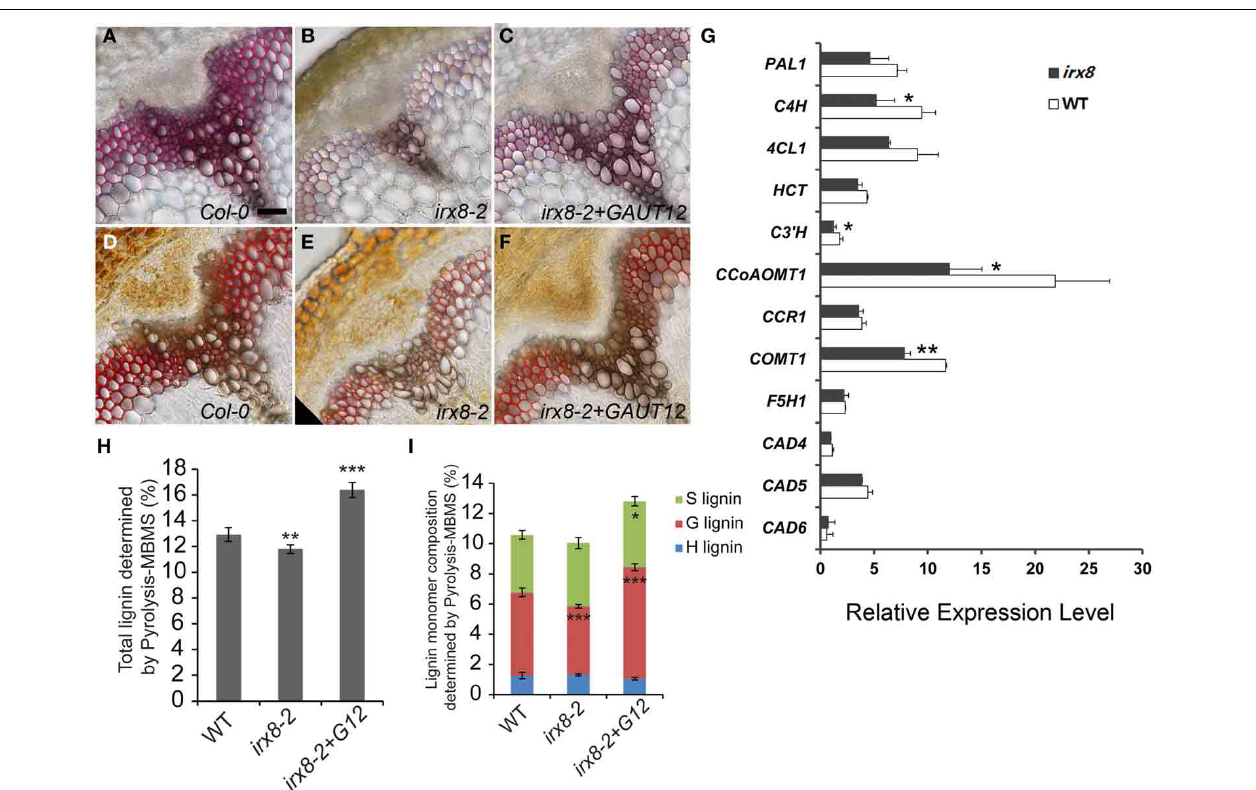
FIGURE 4 | Measurement of lignin and lignin biosynthetic gene expression in the irx8 mutant. Phloroglucinol-HCl staining of free-hand basal stem cross-sections of WT (A) , irx8-2 (B) , and irx8-2 + GAUT12 (C) . Mäule staining of free-hand basal stem cross-sections of WT (D) , irx8-2 (E) , and irx8-2 + GAUT12 (F) . Bar = 50 μ m for A–F . (G) Expression analyses in Arabidopsis WT and irx8 lower stems of lignin biosynthetic genes using Real-Time PCR. Genes labeled with asterisks have significantly lower expression in irx8-5 compared to WT ( ∗ p < 0 . 05; ∗∗ p < 0 . 01). The relative expression level of each gene was normalized using Actin2 as the reference gene and the expression of C3 (cid:5) H in wild-type basal stem was set to 1. Values are mean ± standard deviation ( n = 3). Lower-stem refers to the lower half of the inflorescence. PAL, phenylalanine ammonia lyase; C4H,